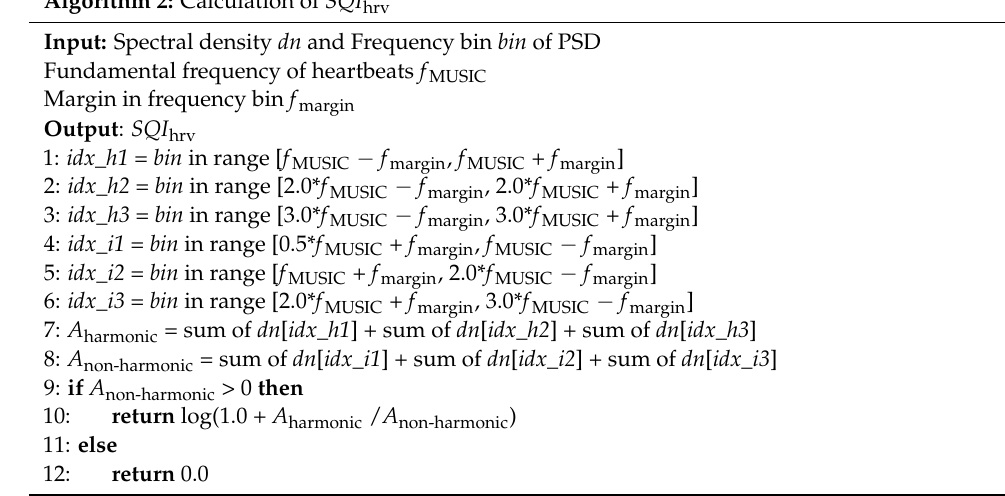
Figure 2. Photoplethysmography (PPG) data and the associated power spectral density (PSD) shape during sleep in a single major depressive disorder patient (ID = 45). Left: 572nd epoch, signal quality index for heart rate variability (SQI hrv ) = 2.6; right: 552nd epoch, SQI hrv = 0.3. Algorithm 2: Calculation of SQI hrv